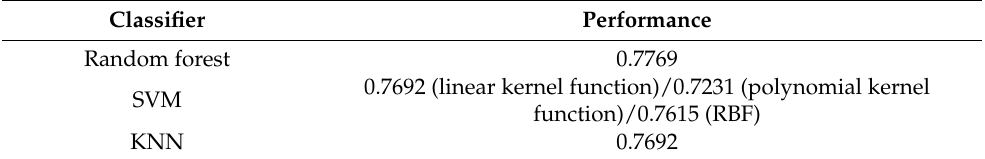
Table 2. Performance of different machine learning method with label